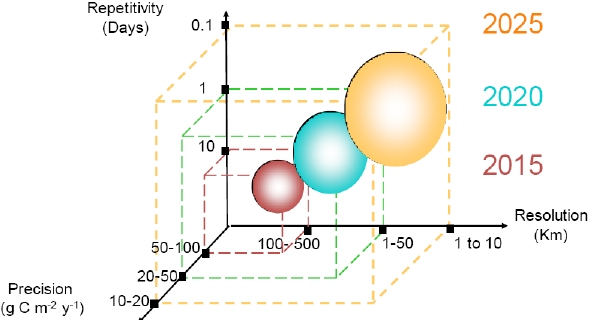
Figure 8. Notional deployment of a global carbon monitoring sys- Fig. 8. Notional deployment of a global carbon monitoring system in three phases with increasing 3 tem in three phases with increasing sampling, resolution and accu- sampling, resolution and accuracy. The resolution and target precision are expected to be reached 4 racy. The resolution and target precision are expected to be reached in the best-sampled regions at first. 5 in the best-sampled regions at